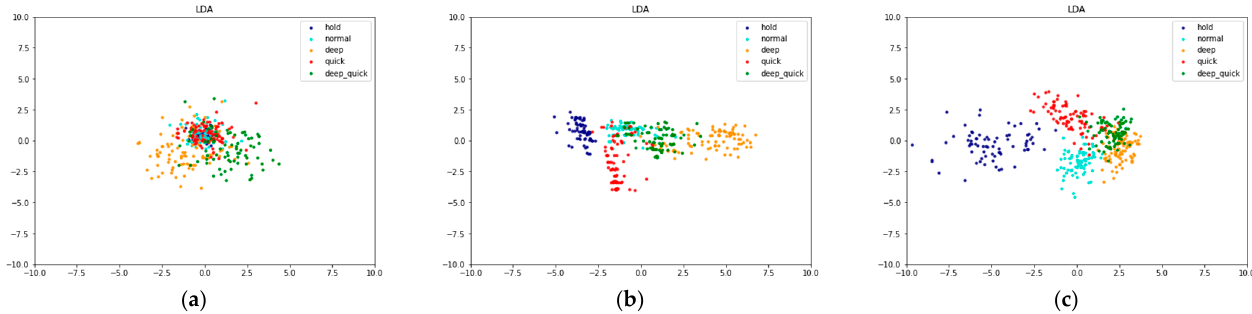
Figure 9. LDA data scattering point for ( a ) raw data, ( b ) data with statistic feature extraction, and ( c ) data with MFCC feature extraction.